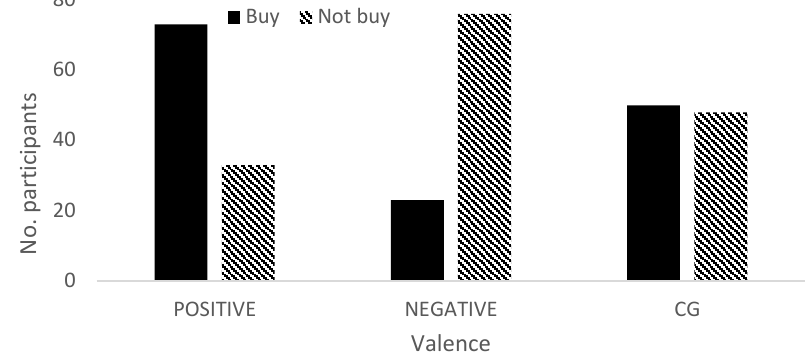
Figure 3. Consumer purchase behavior according to OL eWOM valence. Product type. Figure 4 represents the consumer behavior according to the product type. A total of 77% of the experiential group made a purchase, and 23% did not. On the other hand, 73% of the search product group did not